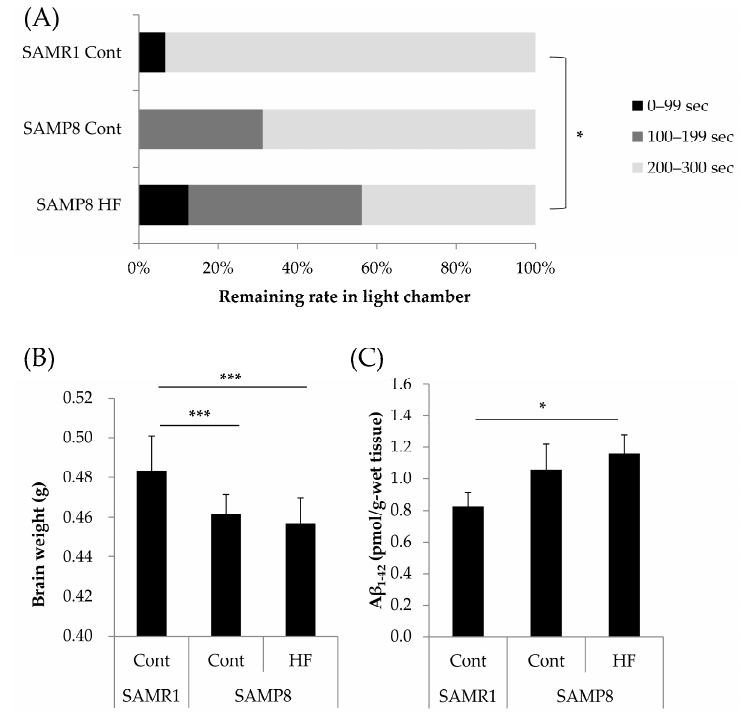
Figure 1. Effects of a HF diet on memory function, total brain weight, and A β 1-42 accumulation in a senescence-accelerated mouse model at six months of age. ( A ) Memory retention was measured by a